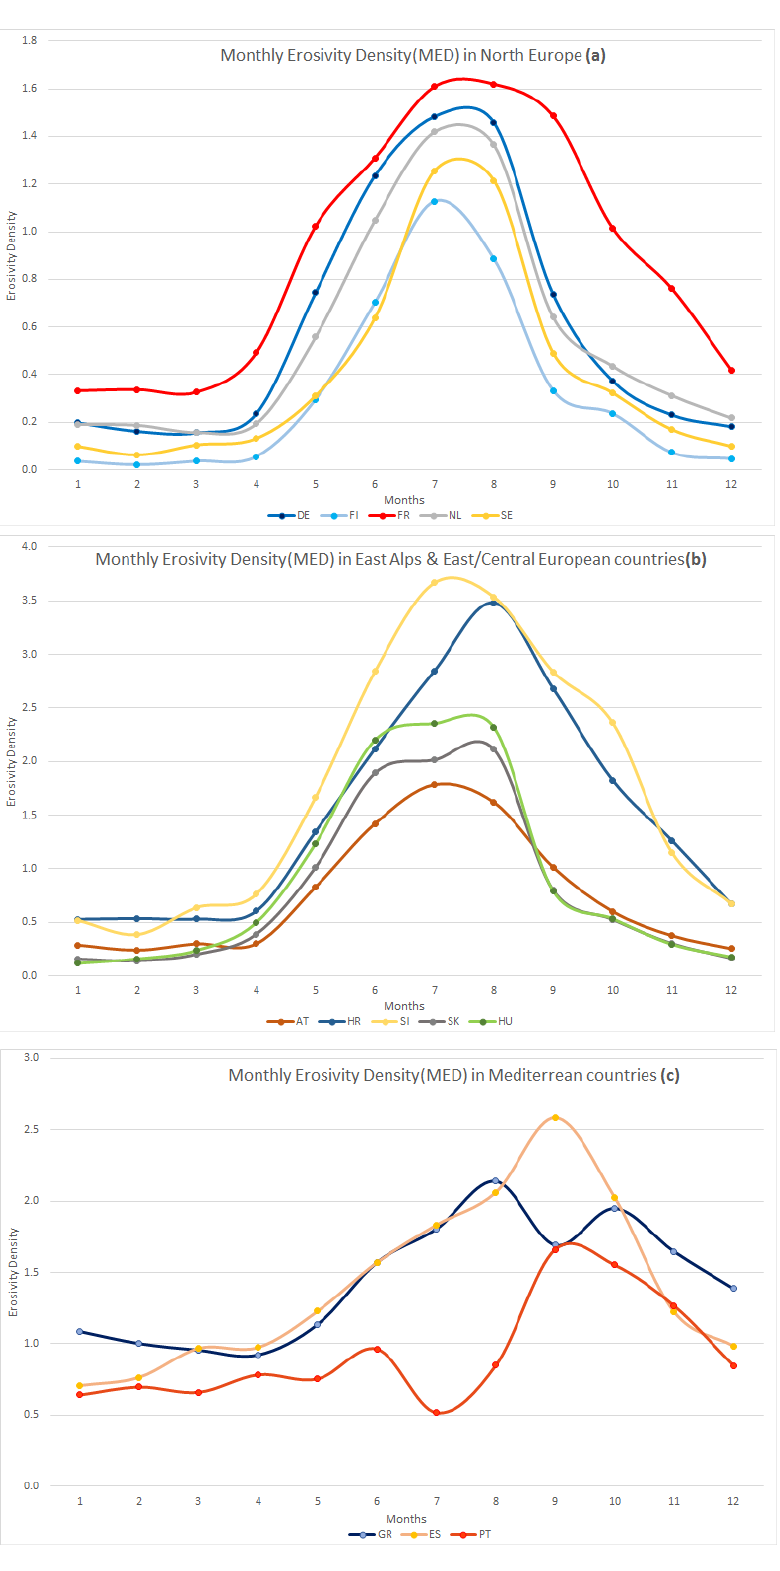
Figure 8. The main regional patterns of monthly erosivity density (MED): ( a ) North Europe (DE—Germany, FI—Finland, FR—France, NL—The Netherlands, SE—Sweden); ( b ) East Alps and East/Central European Countries (AT—Austria, HR—Croatia, SI—Slovenia, SK—Slovakia, HU— Hungary); ( c ) Mediterrean countries (GR—Greece, ES—Spain, PT—Portugal).